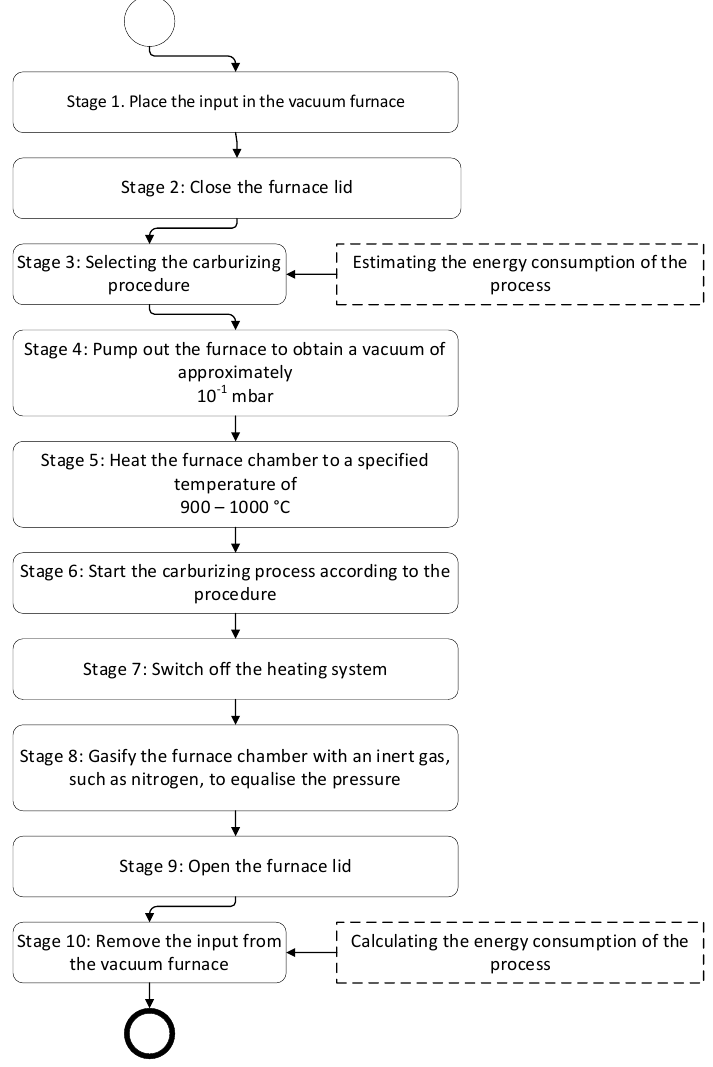
Figure 1. The low-pressure carburisation